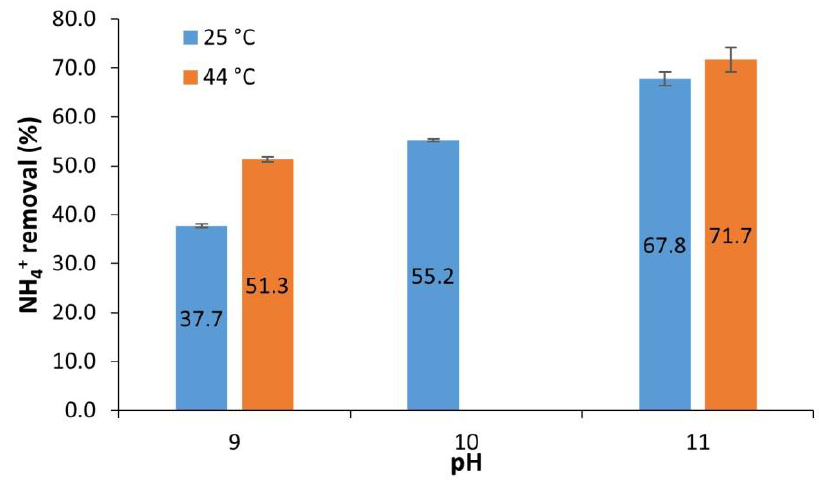
Figure 4. Ammonia removal efficiencies obtained after ammonia stripping with different pH and temperature. Values are presented as the mean ± mean deviation ( n = 2).